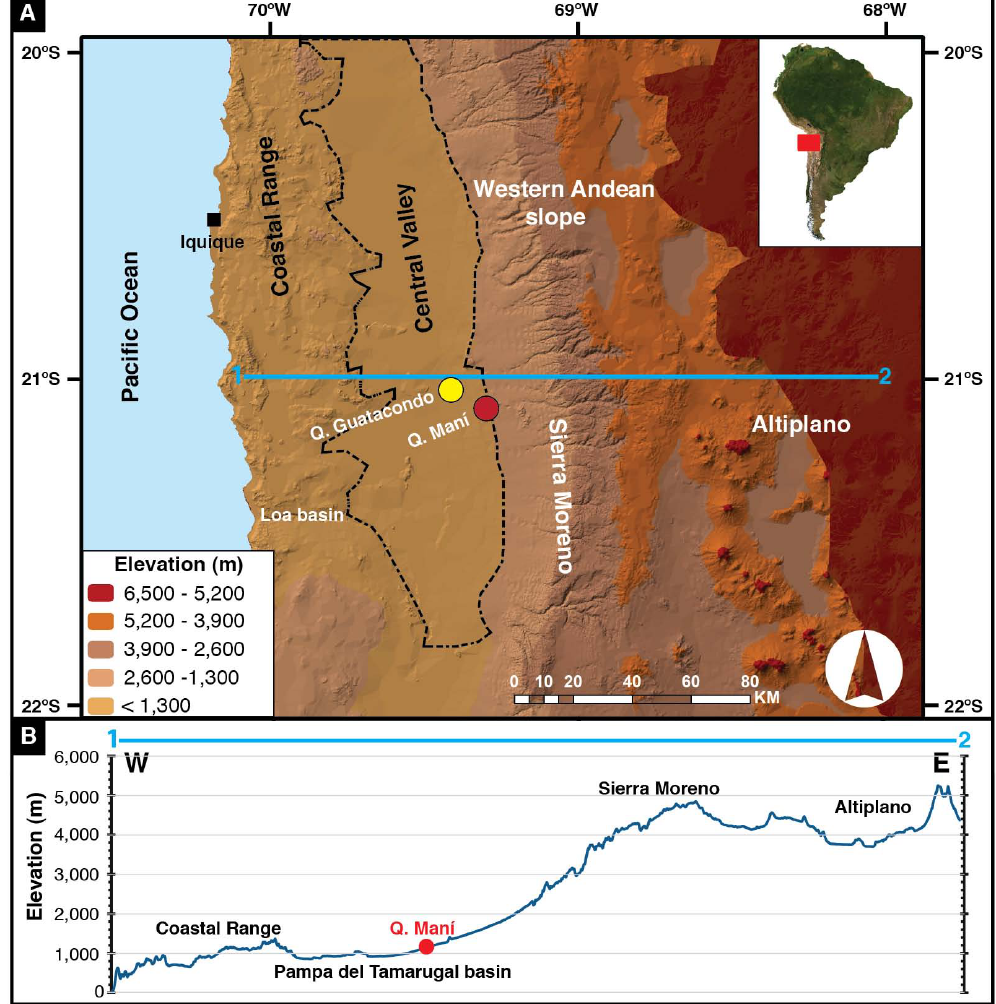
Fig. 1. (a) Study area indicating localities discussed in the text. Red dot: mean location for the 26 geohistorical archives recovered from QM and reported here. Yellow dot: Ramaditas archaeological site at Quebrada Guatacondo. Black dashed line: PdT basin boundaries. Horizontal white line: limit between the northern and southern PdT basin. (b) A topographic cross-section located along the transect labeled from 1 to 2 in (a)